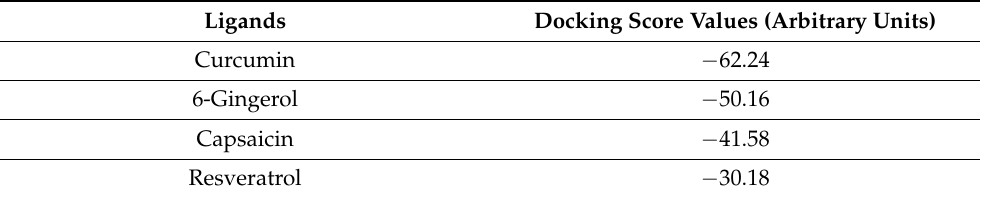
Table 2. Docking score values of the best-scored PDE4D–polyphenol complexes obtained with CANDOCK algorithm and RMR6 scoring